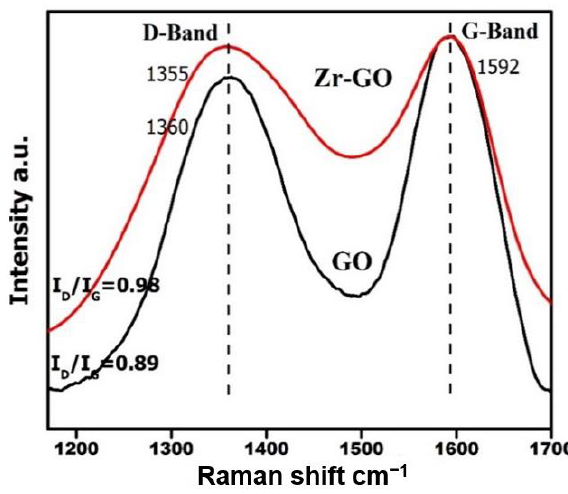
Figure 3. Raman spectrum of GO and Zr-GO.